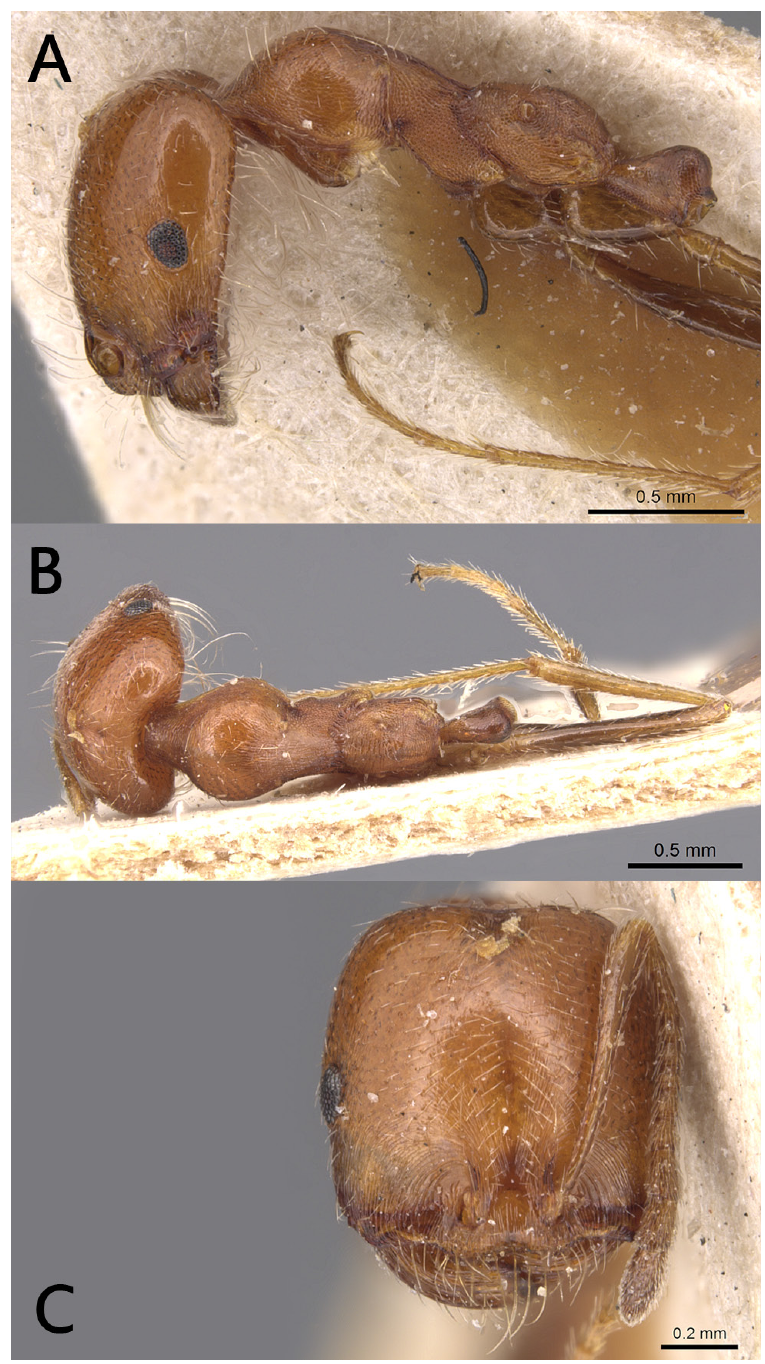
Fig. 7. Trichomyrmex chobauti (Emery, 1897), syntype, worker (CASENT0904606) . A . Body in profile. B . Body in dorsal view. C . Head in full-face view (photos: Will